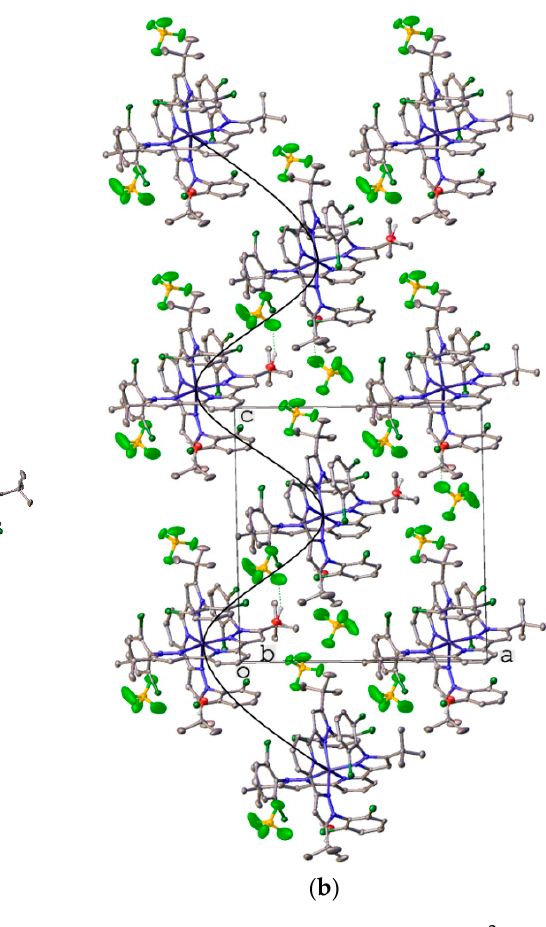
Figure 2. ‘Terpyridine-embrace’-like ( a ) and spiral-like ( b ) packing of the cations [Fe( L ) 2 ] 2+ in [Fe( L ) 2 ](BF 4 ) 2 · 0.5H 2 O (red). For other solvatomorphs, see Figures S3 and S4.